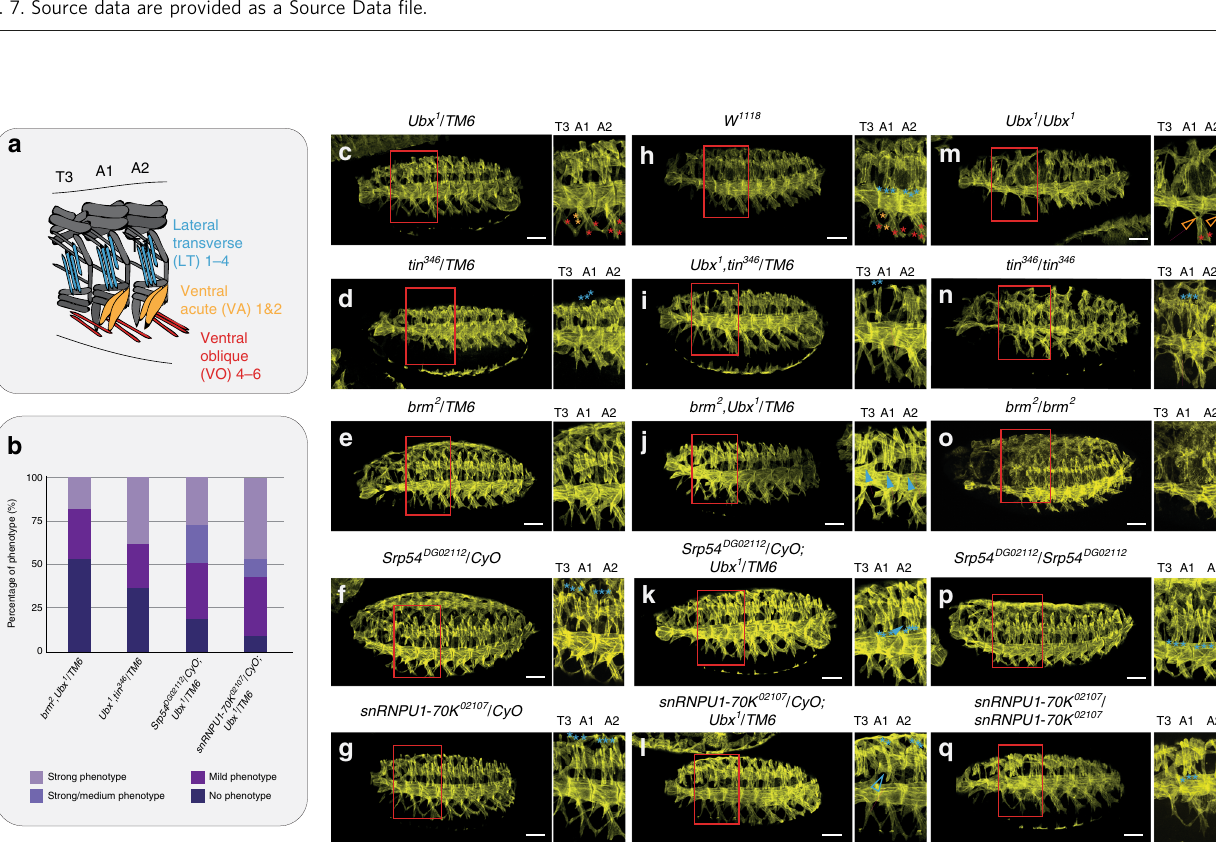
Fig. 5 Direct and functional interaction between Ubx and Tin. a ChIP-seq of Ubx 2 and ChIP-on-chip pro fi les of Tin 45 at the dpp genomic locus in mesodermal cells. Isoforms of the dpp gene are shown (blue) and the known dpp visceral enhancer (light blue). The box highlights Ubx and Tin binding to the dpp674 enhancer. b – g Immunostaining of stage 11 tin 346 /TM6-Dfd > lacZ ( b ), Ubx 1 /TM6-Dfd > lacZ ( c ), Ubx 1 ,tin 346 /TM6-Dfd > lacZ ( d ), tin 346 /tin 346 ( e ), Ubx 1 /Ubx 1 ( f ) and Ubx 1 ,tin 346 / tin 346 ,Ubx 1 ( g ) embryos for dpp mRNA (green) and β -Galactosidase protein (red). Images are representative of all embryos analysed ( n = 15) per genotype over 2 sets of pooled embryos from independent collection. h Quanti fi cation of relative signal intensity of dpp mRNA levels shows signi fi cant expression changes between tin 346 /TM6-Dfd > lacZ and Ubx 1 ,tin 346 /TM6-Dfd > lacZ h eterozygous mutants ( n = 15 independent embryos). i S2R + cells were co-transfected with a dpp674 -containing plasmid driving luciferase expression, myc-Ubx and V5-Tin encoding plasmids (100 ng). Increasing amounts of Ubx WT or Ubx N51A (left) or Tin expressing plasmids (right) was used. Transfection ef fi ciency was normalized with Renilla activity originating from co-transfected pRT-TK plasmid. Results are indicated relative to basal activity of the dpp674 -luciferase plasmid. Graphics represent mean + / − sem of three ( n = 3) independent experiments performed in triplicates. j Schematic of Ubx fragments used for GST in vitro pull-down assays. Hexapeptide (HX) motif is highlighted in blue, the Homeodomain (HD) in green and the UbdA motif in dark-red. k Pull-down assay using the indicated GST-fused Ubx derivatives and in vitro puri fi ed Tin. Input is loaded as indicated. l , m Quanti fi cation of interactions relative to GST-Ubx FL (full length) signal is indicated in ( l ) for V5-Tin ( n = 3) and in ( m ) for myc-Exd ( n = 2 independent experiments) as mean ± SD. n Pull-down assay using GST-fused Ubx derivatives and in vitro His-puri fi ed GFP (negative control), myc-Exd (positive control) and V5-Tin proteins. Input is loaded as indicated. Protein size is indicated relative to ladder position. Pull-down assays showed direct interaction of Ubx WT as well as Ubx N51A with Exd and Tin but not with GFP (lane 3 – 4). Ubx-Tin interaction is at least 10 times stronger than Ubx-Exd interaction as exempli fi ed by intensity of signal in pull-downs compared with input (comparison of lane 3 – 4 with 1). Statistical tests were performed with one-way ANOVA (** p < 0.01, * p < 0.05). Scale bar = 50 µ m. See also Supplementary Fig. 7. Source data are provided as a Source Data fi le.